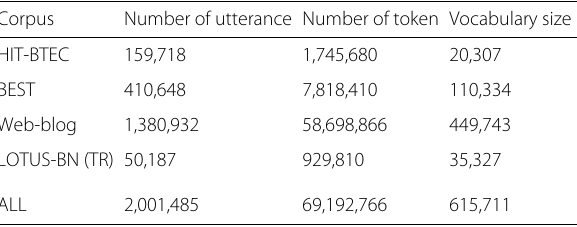
Table 4 Text resources for language model training